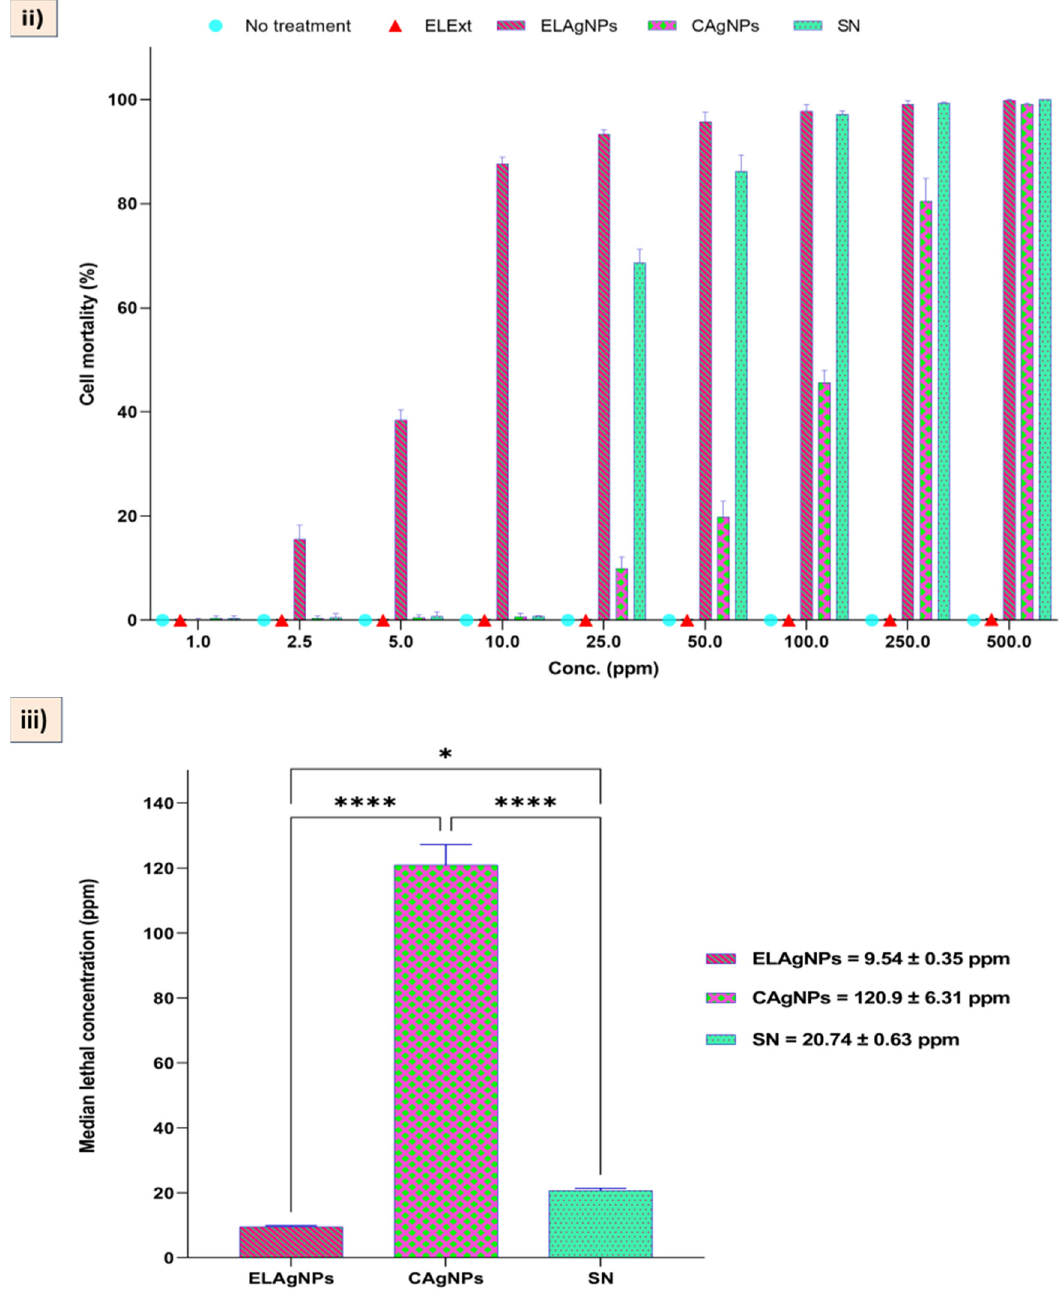
Figure 8. ( i ) Morphological changes in Vero cells due to ELAgNPs exposure at different concentrations, (data are presented as mean ± SD of three replicates). ( ii ) Cell mortality (%) of ELExt, ELAgNPs, CAgNPs, and SN after 48 h of incubation. ( iii ) LC 50 of ELAgNPs, CAgNPs, and SN (where **** = p < 0.0001 and * = 0.01 < p < 0.05).